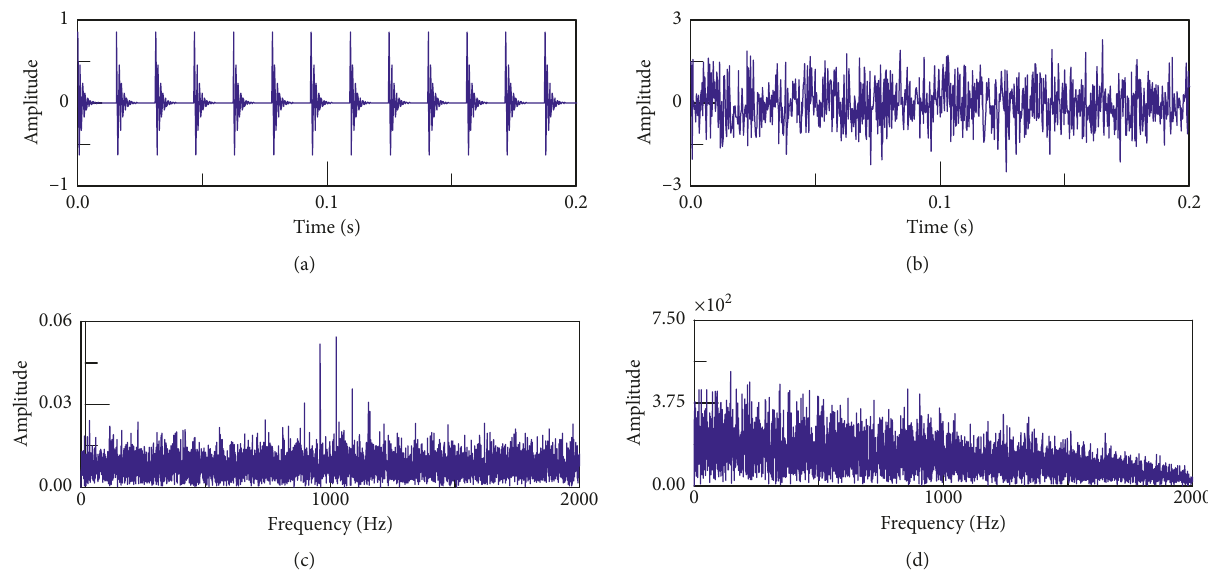
Figure 2: The simulated signal: (a) raw signal, (b) simulated signal with added noise, (c) Fourier spectrum of the noised signal, and (d) squared envelope spectrum of the noised signal.